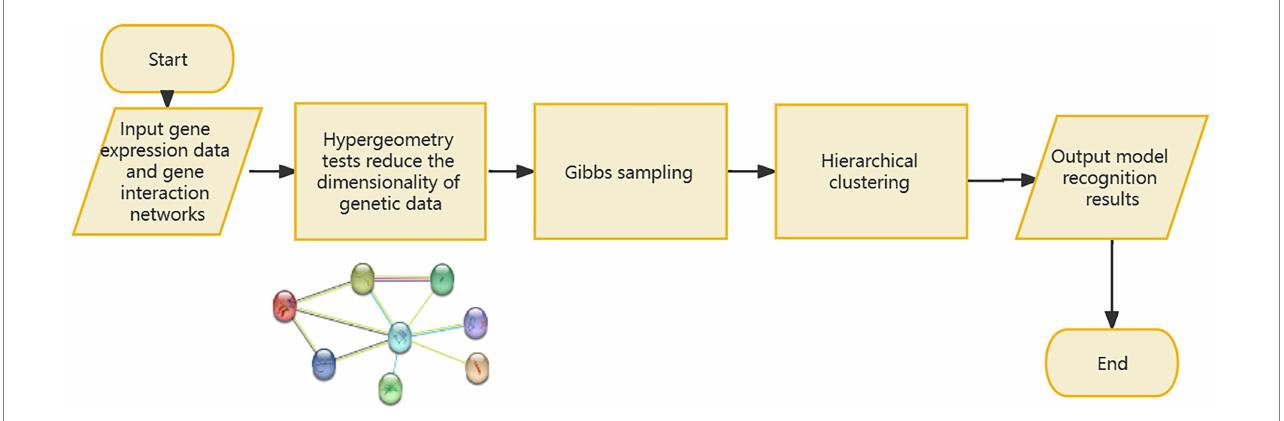
FIGURE 2 Introduction to the model